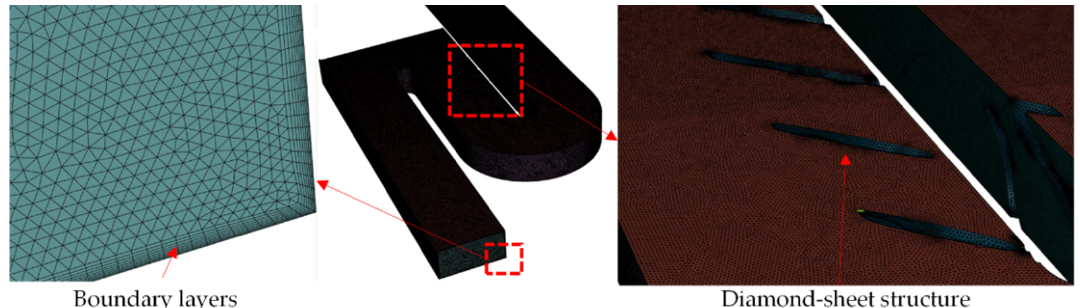
Figure 10. An example of mesh systems for the 3D models.